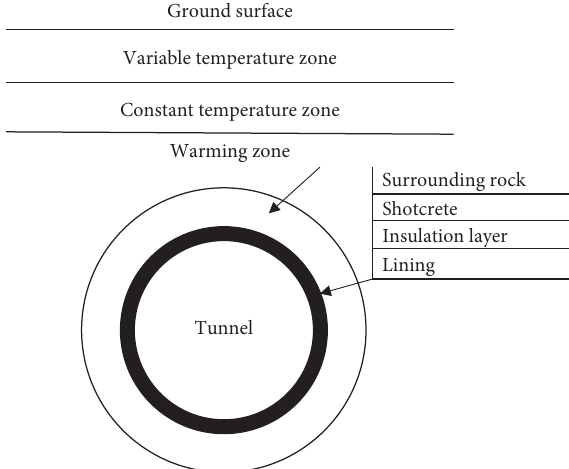
Figure 2: Cross-section distribution diagram of the surrounding rock, the shotcrete, the insulation layer, and the